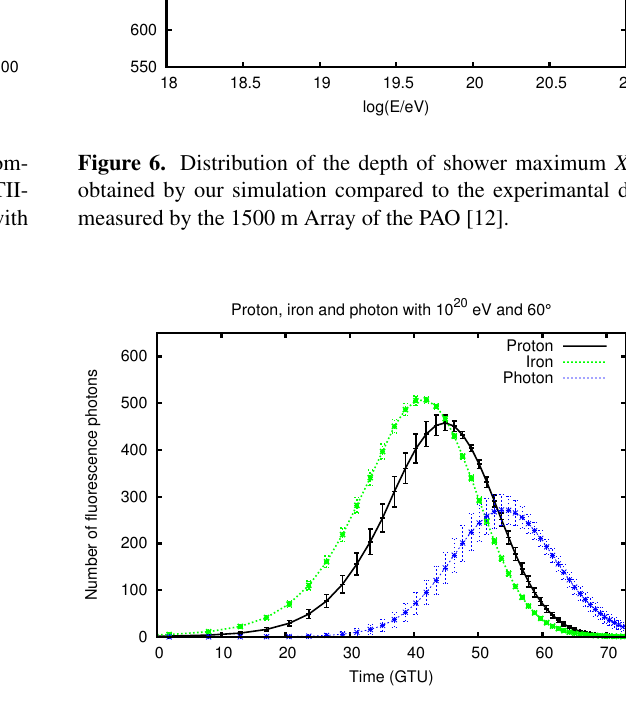
Fig.6 with consistency between calculations and experi- mental data.